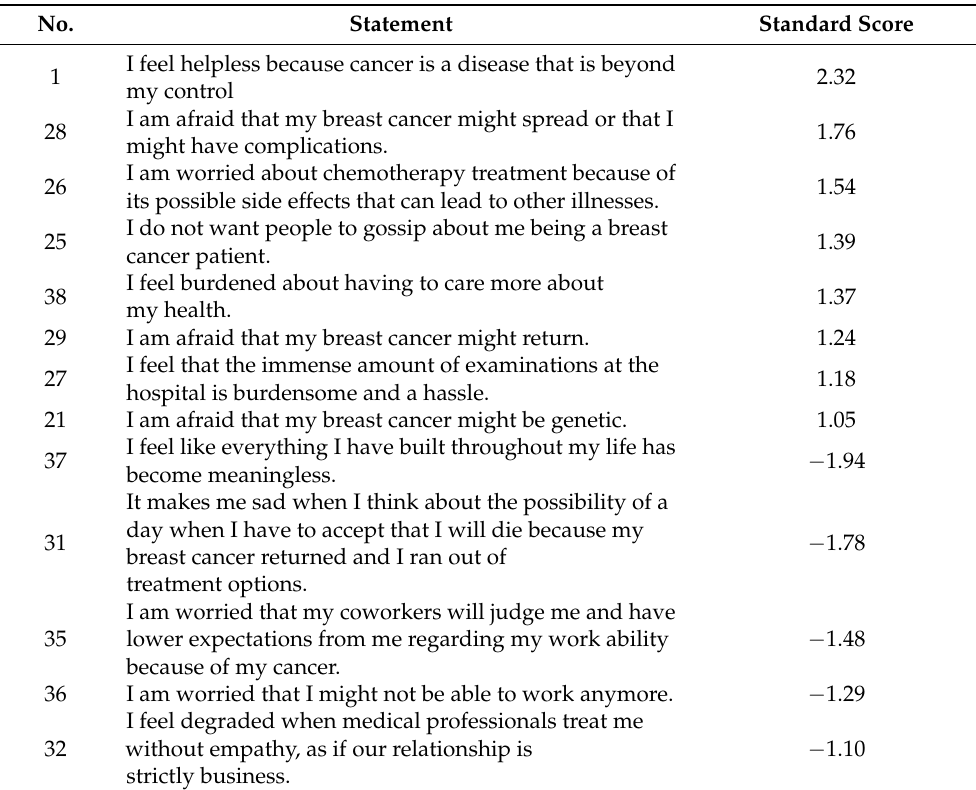
Table 7. Representative statements and standard scores (at least ± 1.00) of Type